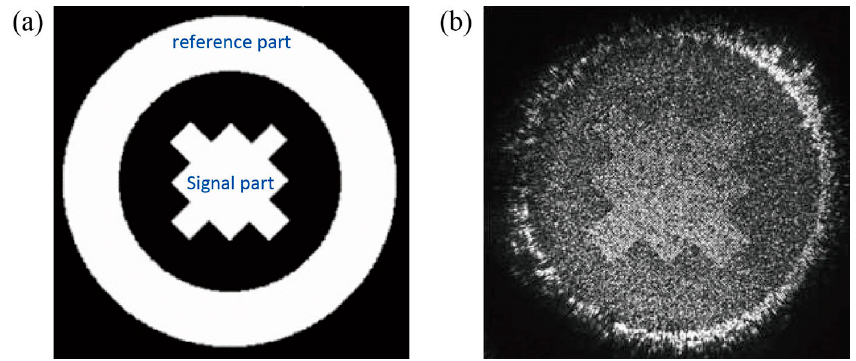
Figure 4. The signal image of magnetic hologram. ( a ) Recording pattern of the collinear hologram and ( b ) reconstruction of the signal image [24].